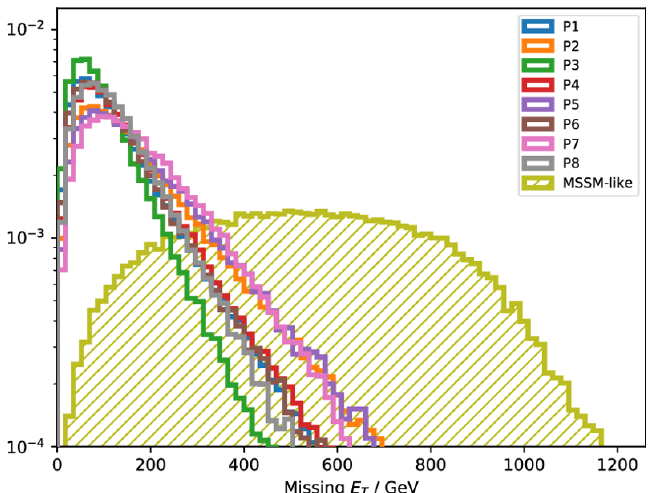
Figure 1. E miss distribution for the eight benchmark points de(cid:12)ned in [15] along with an MSSM- T like simpli(cid:12)ed